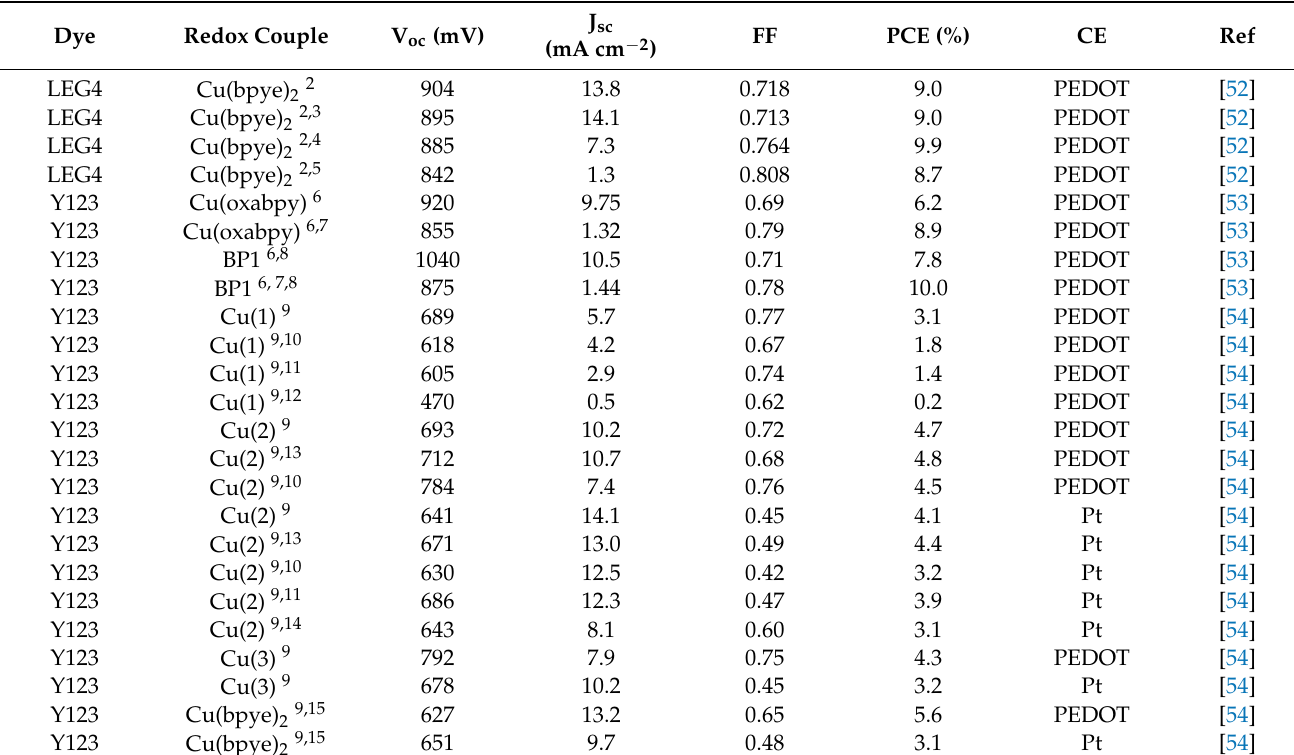
Figure 7. Other copper complexes employed as redox mediators. Table 3. Photoelectrochemical data of solar cells filled with other types of copper complexes employed as redox mediators. 1